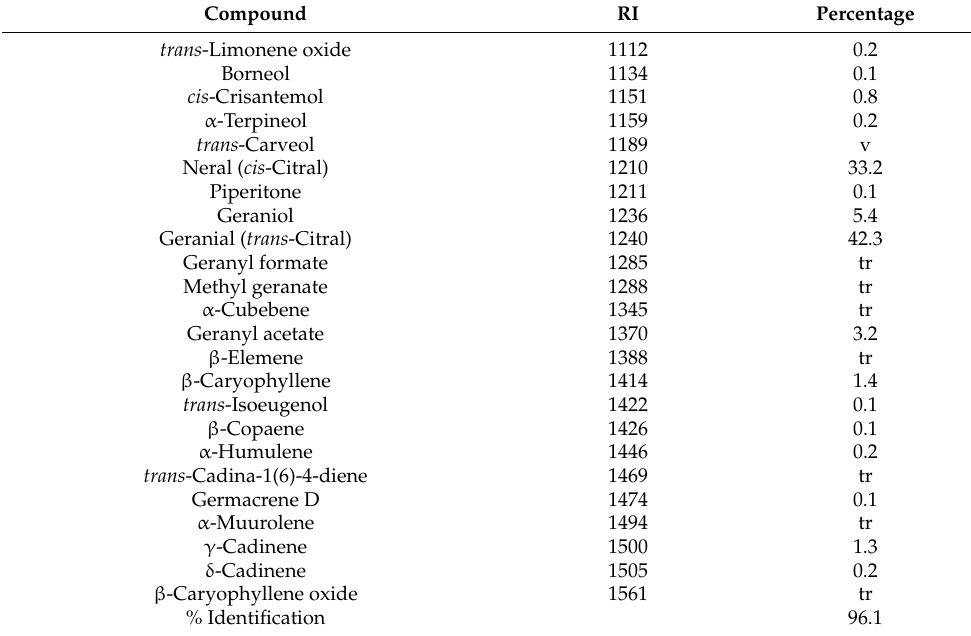
Table 1. Chemical composition of the essential oil obtained from the Cymbopogon citratus aerial components and analyzed by gas chromatography–mass spectrometry